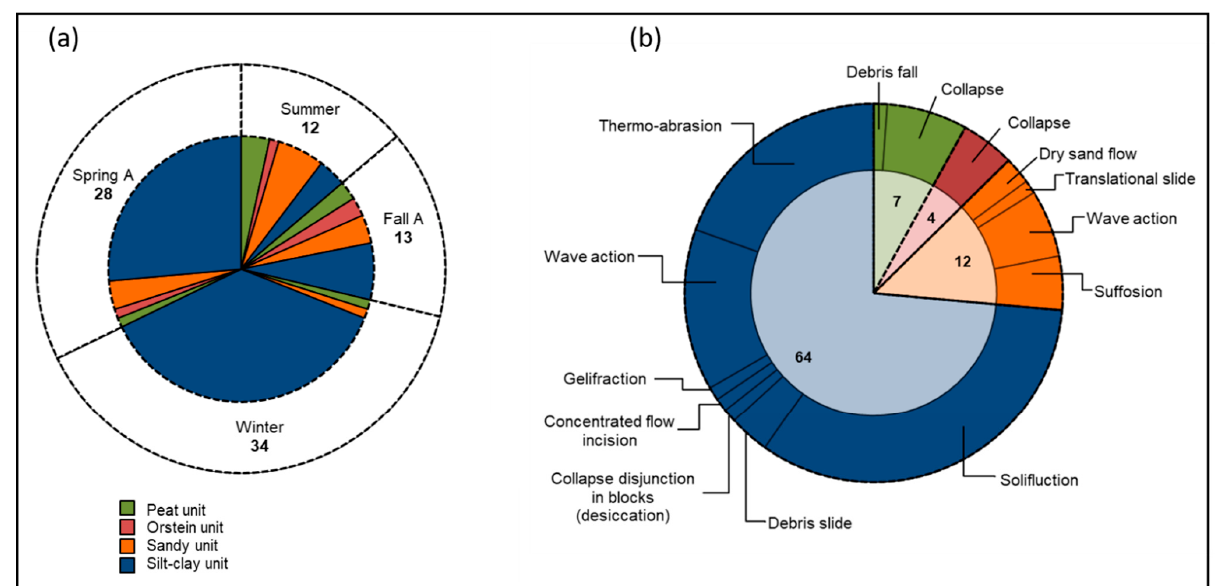
Figure 7. Number of events per lithological unit per season ( a ), and processes affecting the different lithologies in Zone A ( b ).